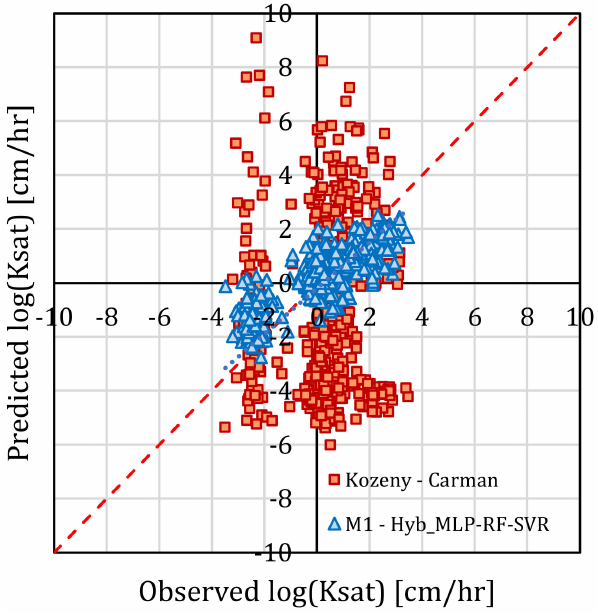
Figure 9. Comparison between the results obtained with the M1 model, Hyb_MLP-RF-SVR variant, and those obtained with the Kozeny-Carman